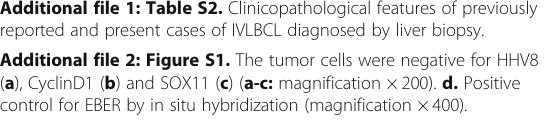
Additional file 1: Table S2. Clinicopathological features of previously reported and present cases of IVLBCL diagnosed by liver biopsy. Additional file 2: Figure S1. The tumor cells were negative for HHV8 ( a ), CyclinD1 ( b ) and SOX11 ( c ) ( a-c: magnification × 200). d. Positive control for EBER by in situ hybridization (magnification ×